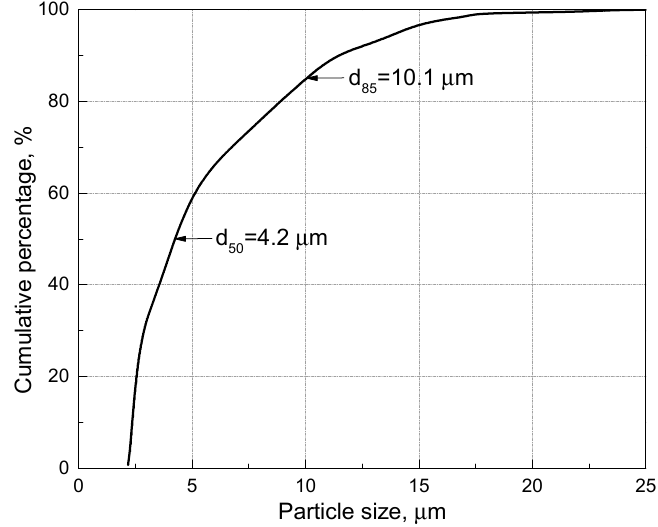
Figure 1. Cumulative percentage of malachite particle size for hydrophobic flocculation and microflotation.